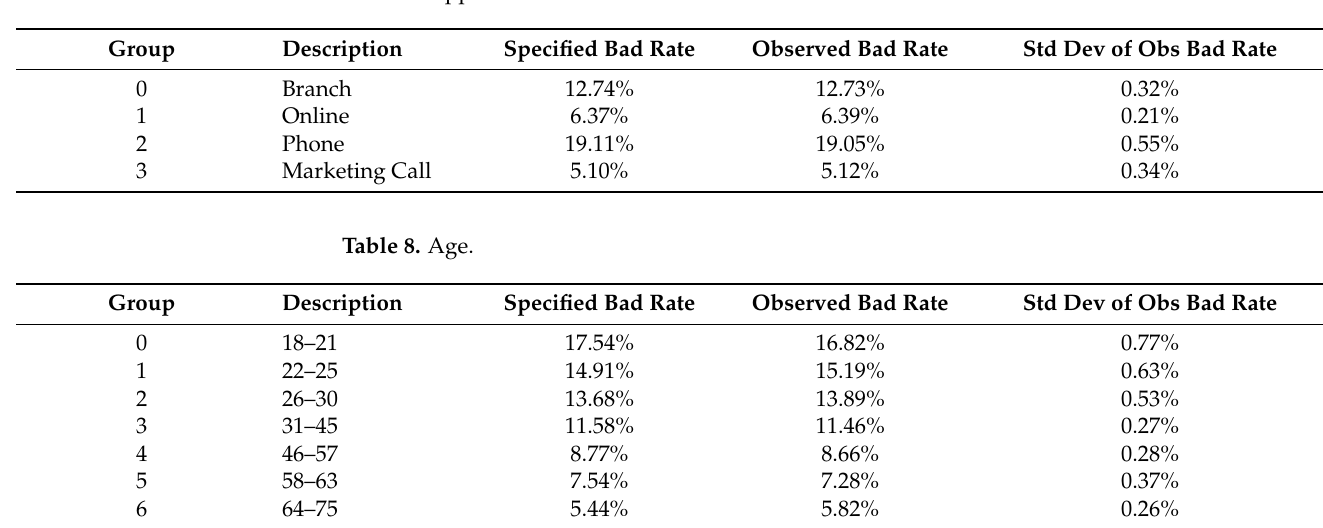
Table 7. Application method.